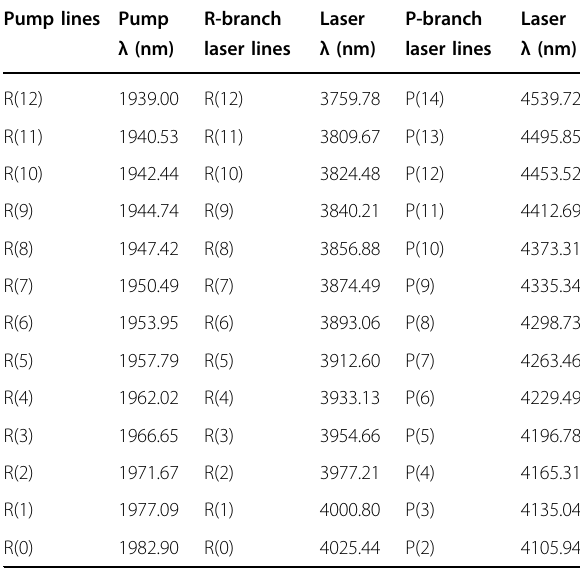
Table. 1 Calculated R-branch absorption lines and corresponding lasing lines of H 79